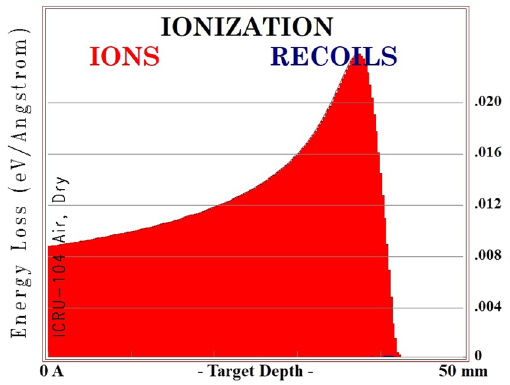
Figure 2. Range of alpha particles in air obtained using SRIM